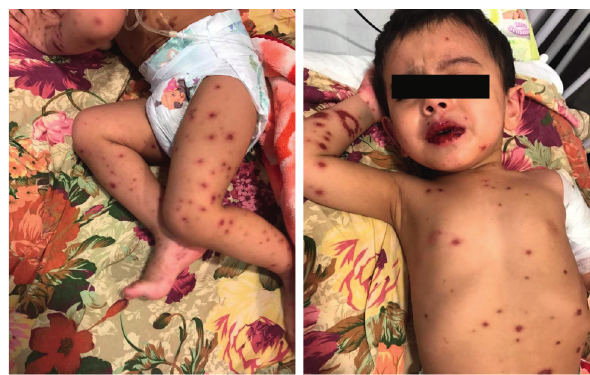
Figure 2: Skin lesions in the patient on the fourth